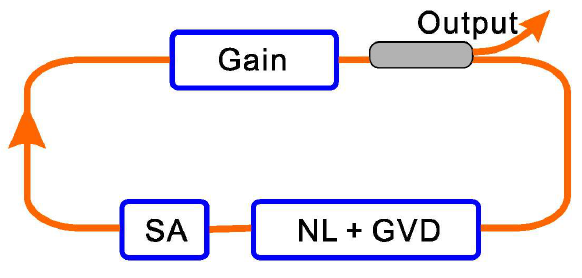
Figure 2: Schematic of a mode-locked laser. NL: Nonlinearity, GVD: Group velocity dispersion, SA: Saturable